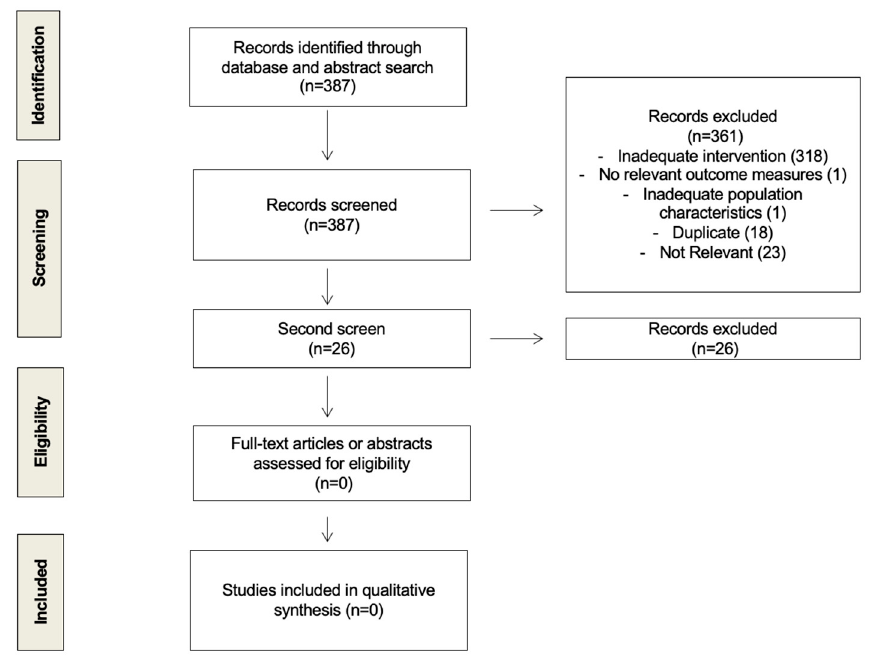
Figure 1. Flow diagram of study selection process.